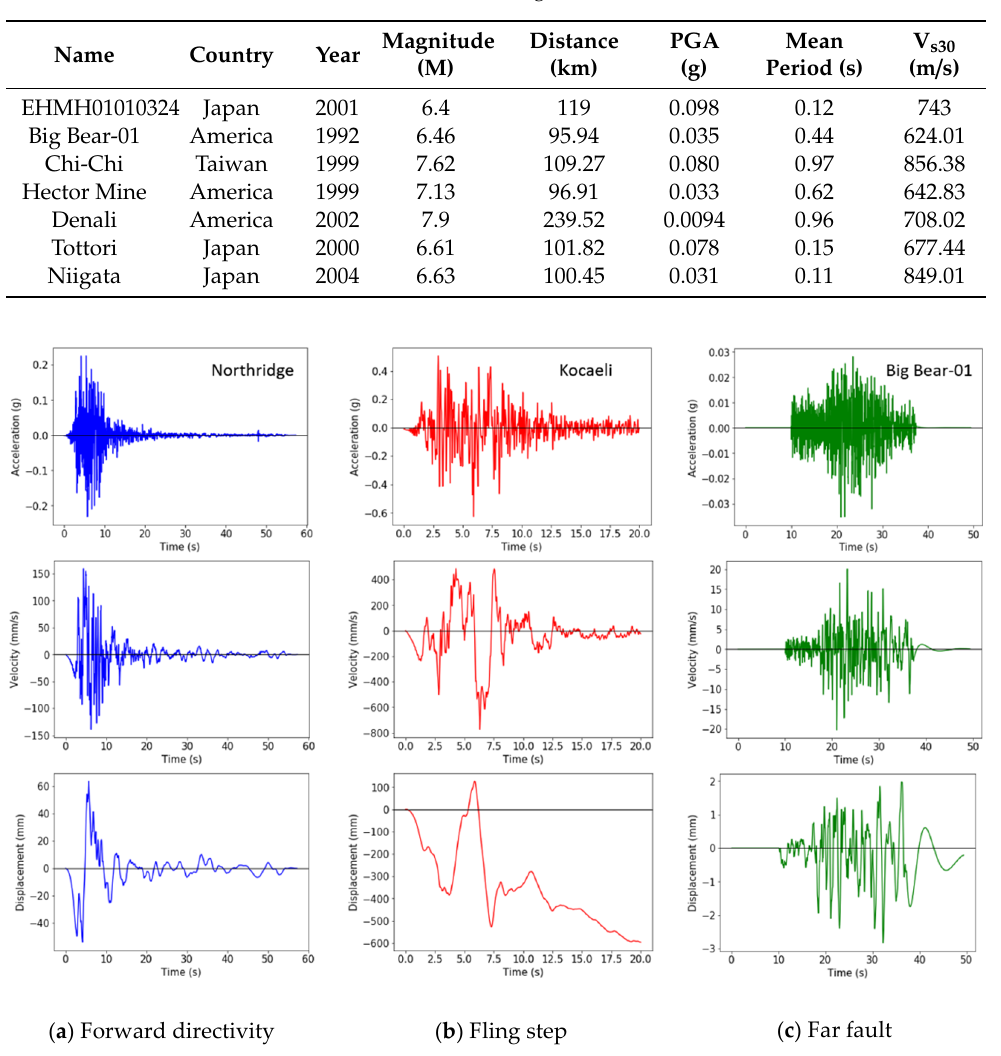
Table 2. List of far-fault ground motions.